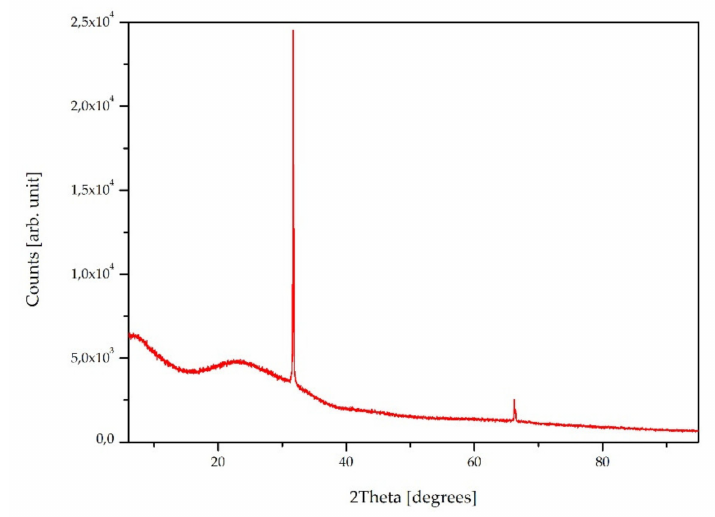
Figure 11. XRD pattern of the sample